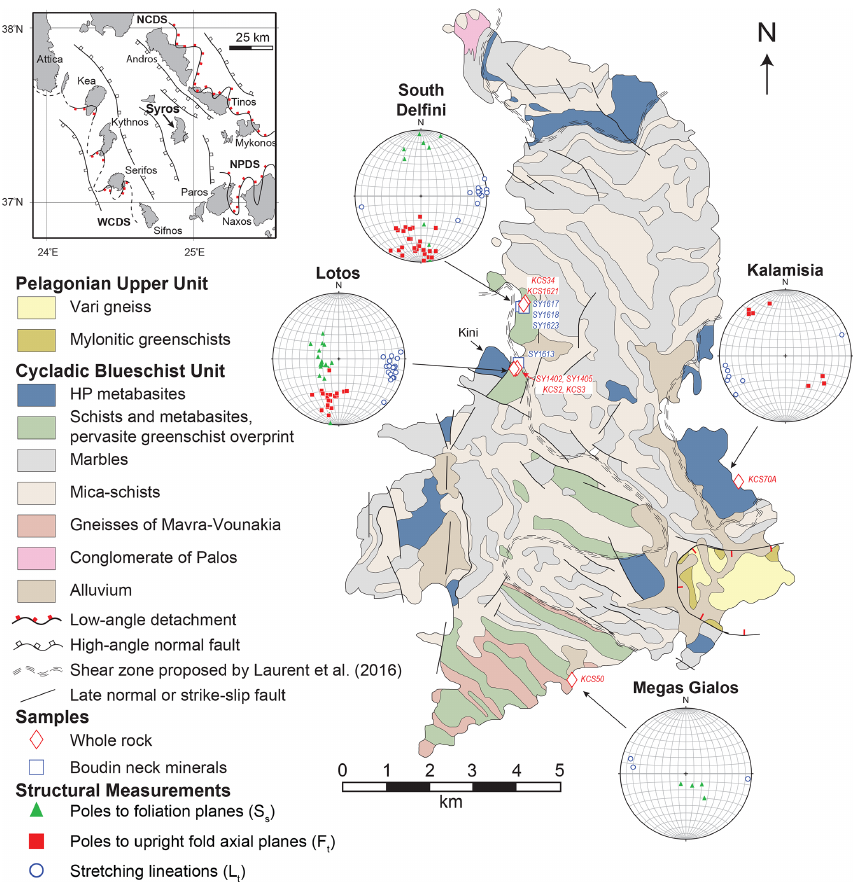
Figure 1. Simplified geologic map of Syros, Greece (modified from Keiter et al., 2011). Inset map shows Syros relative to the North and West Cycladic and Naxos–Paros Detachment systems (NCDS, WCDS, NPDS, modified from Grasemann et al., 2012). Shear zones within the CBU and the Vari detachment are after Laurent et al. (2016) and Soukis and Stockli (2013), respectively. Stereonets from each studied outcrop are shown, and arrows indicate the outcrop